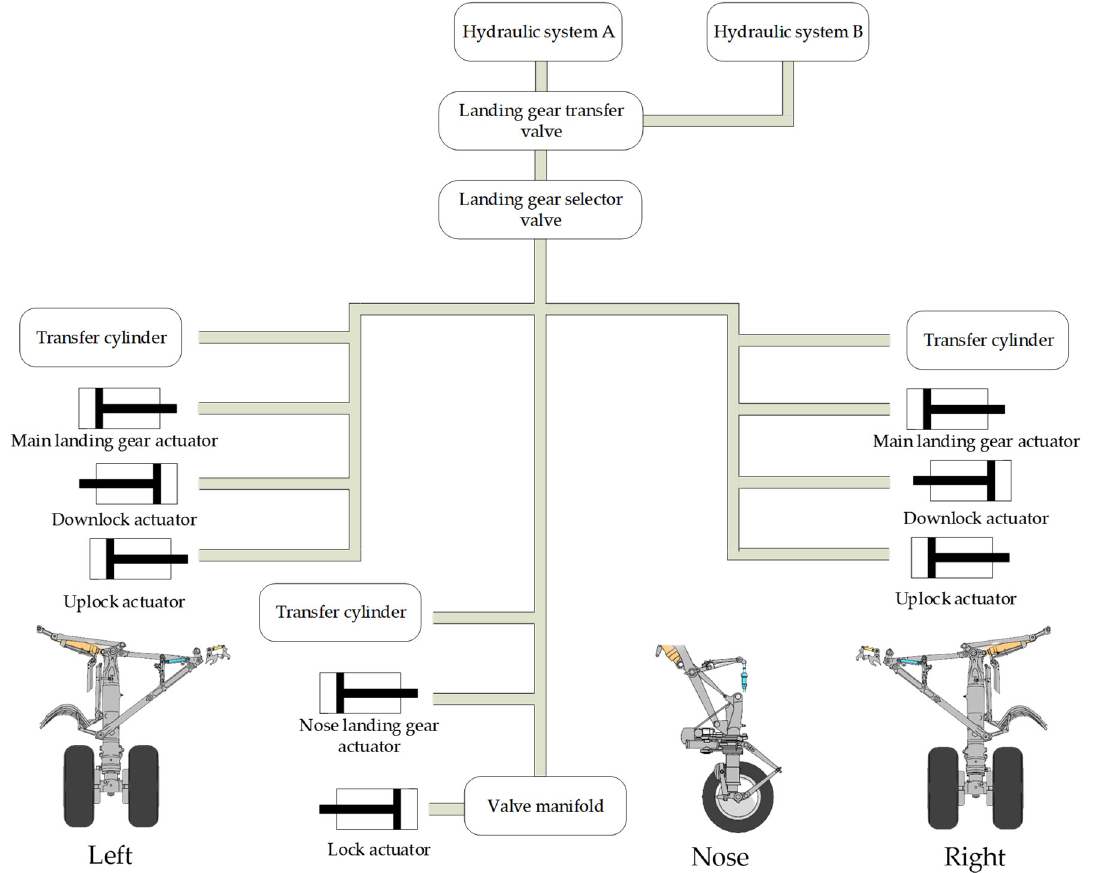
Figure 1. Basic schematic diagram of landing gear R/E system.